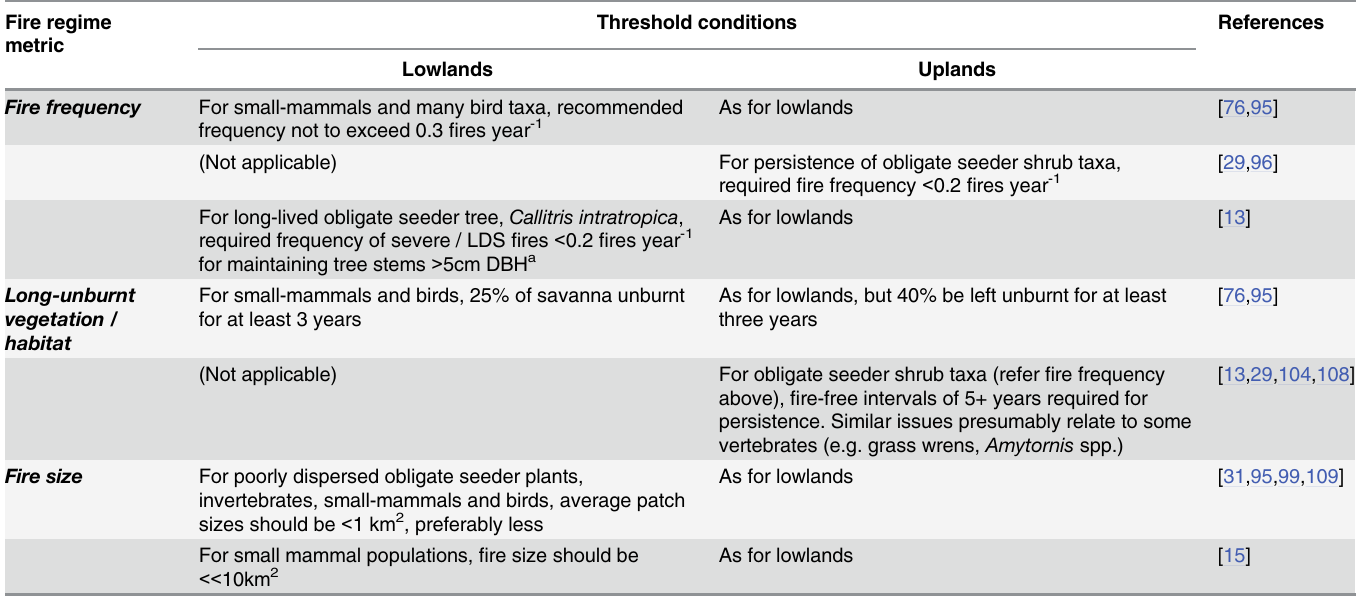
Table 2. Fire regime metrics and recommended threshold conditions. LDS = late dry season; DBH = diameter at breast height, 1.3